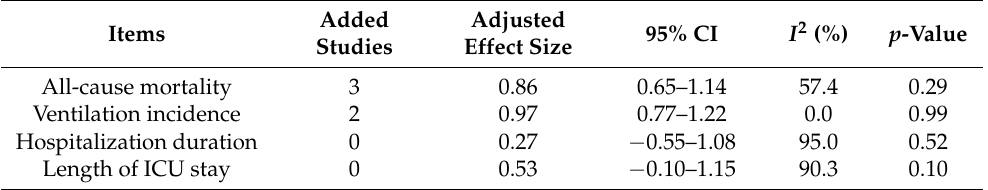
Table 4. Trimmed effect size of vitamin C administration in COVID-19 patients.